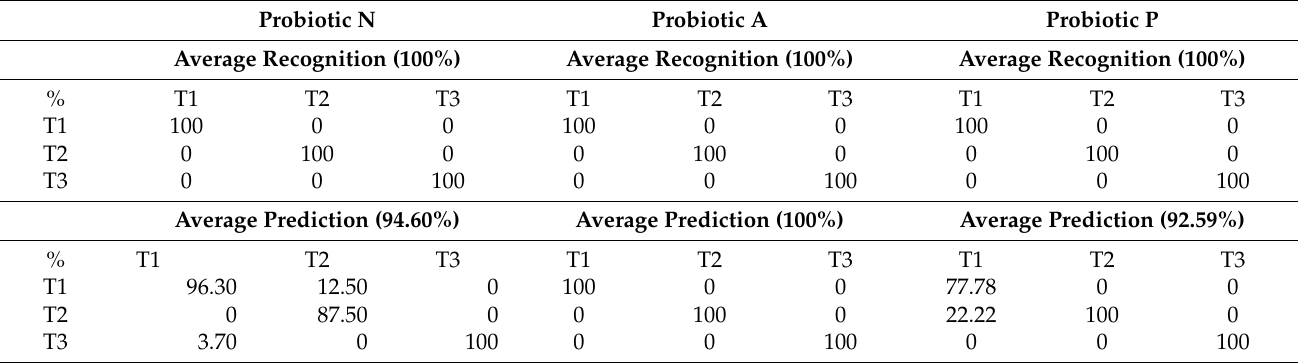
Table 2. Confusion table of the PCA-LDA models for probiotic samples from concentration C1 according to the temperature